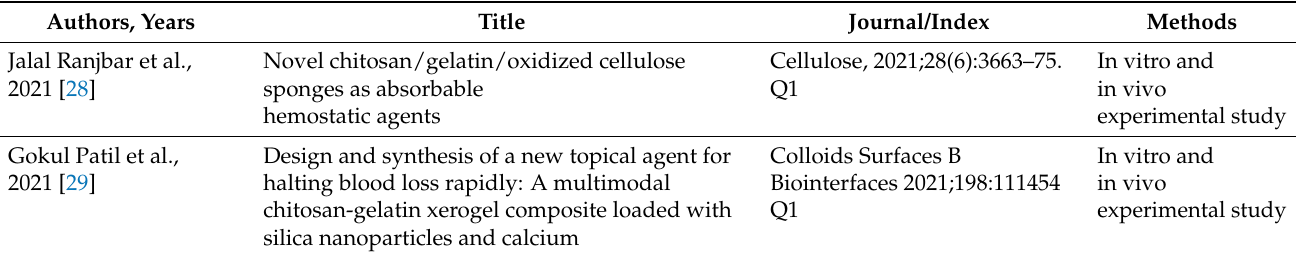
Table 2. Characteristics of